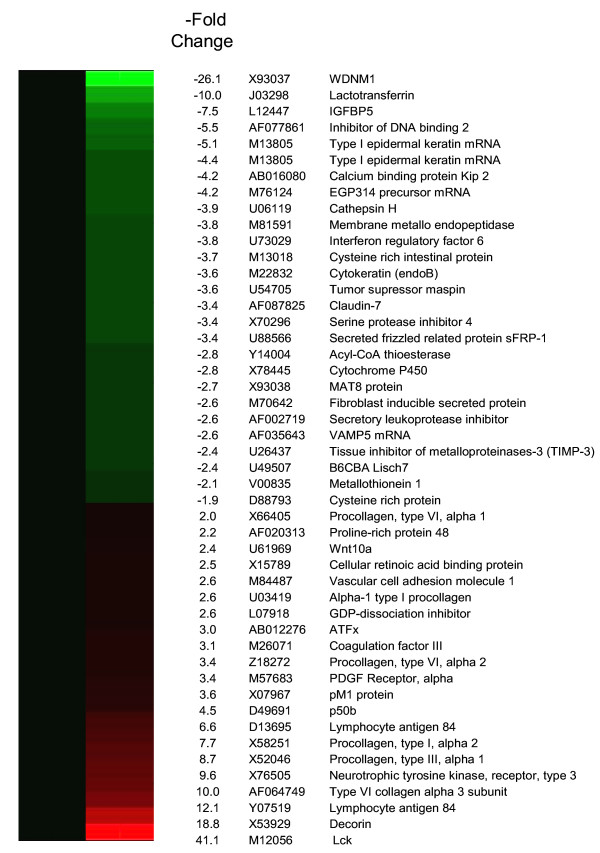
Gene microarray analysis of Comma/PDK1 cells. Total RNA from Comma/vector and Comma/PDK1 cells were used to prepare biotin-labeled cRNA for hybridization as described in Methods. Results are expressed as the -fold change in expression normalized to β-actin expression.